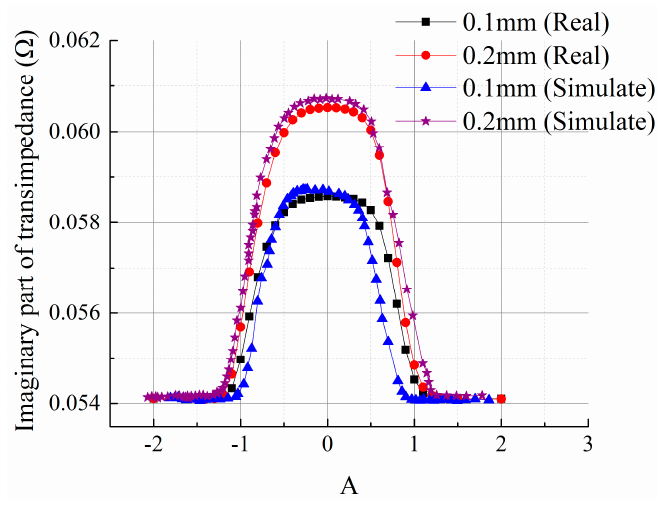
Figure 9. Output curve of transimpedance imaginary part under vertical scan mode.